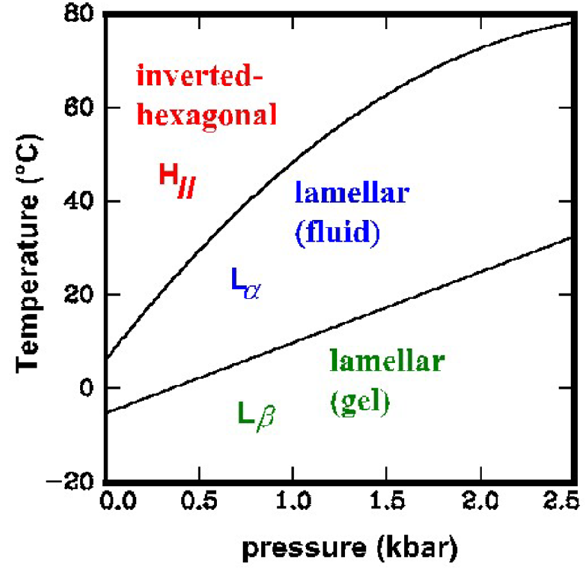
Figure 5: p/T phase-diagram of the phospholipid DOPE (Di-oleoyl- phosphatidy-ethanolamine) in excess water. Within the shown range (0 to 2.5 kbar and − 20 ∘ C to 80 ∘ C) it exhibits two lamellar phases (gel and fluid) and a two-dimensional hexagonal phase